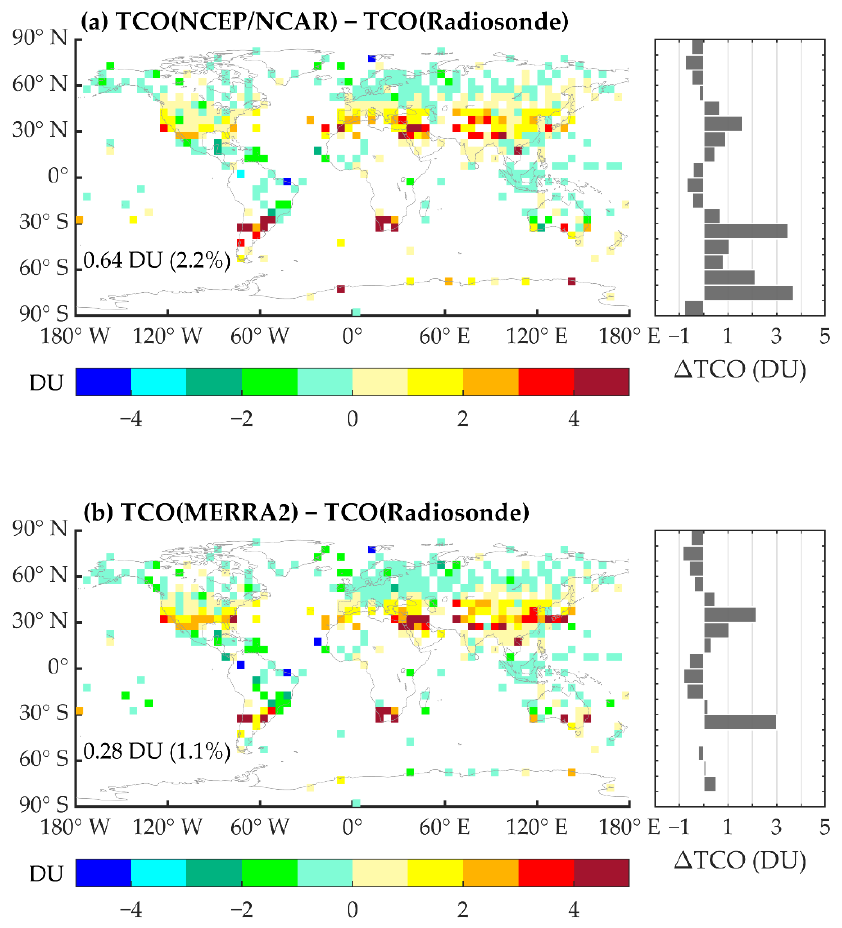
Figure 8. ( a ) Spatial variation in the TCO biases (in DU) between using NCEP/NCAR P LRT and using radiosonde P LRT . Each value is the mean difference in TCO over 1980–2017 at each of the 5 ◦ × 5 ◦ grid cells. In the right panels, 10 ◦ zonal-mean differences are shown. The text indicates the global mean bias in absolute and relative terms. ( b ) The same as ( a ), but for the TCO biases using MERRA-2 P LRT . Vertical ozone profile data is based on TOST at 1-km resolution. Blank grids are missing data mainly due to unavailability of radiosonde data. Both NCEP/NCAR and MERRA-2 data are remapped to the horizontal resolution of TOST, 5 ◦ × 5 ◦ in longitude and latitude [57]. The text in each panel indicates the global mean biases if P LRT from the corresponding reanalysis is used.